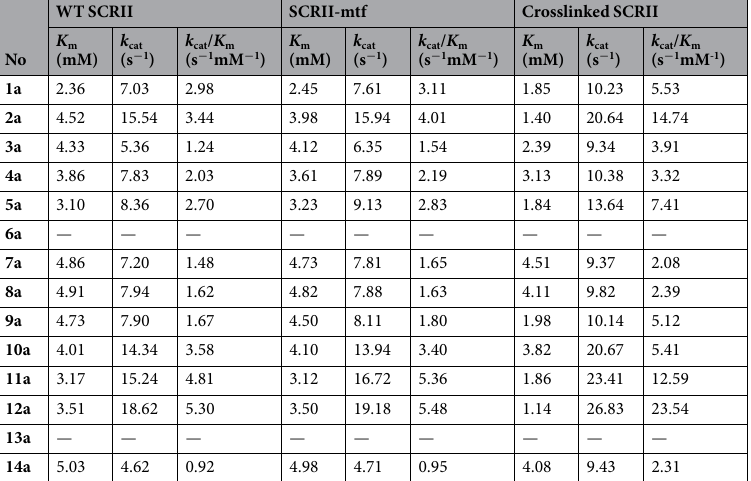
Table 2. Kinetic parameters for WT SCRII, SCRII-mtf and crosslinked SCRII towaids the asymmertric reduction of aryl ketones. Each value was calculated depending on three independent measurements and all standard errors of fits were not more than